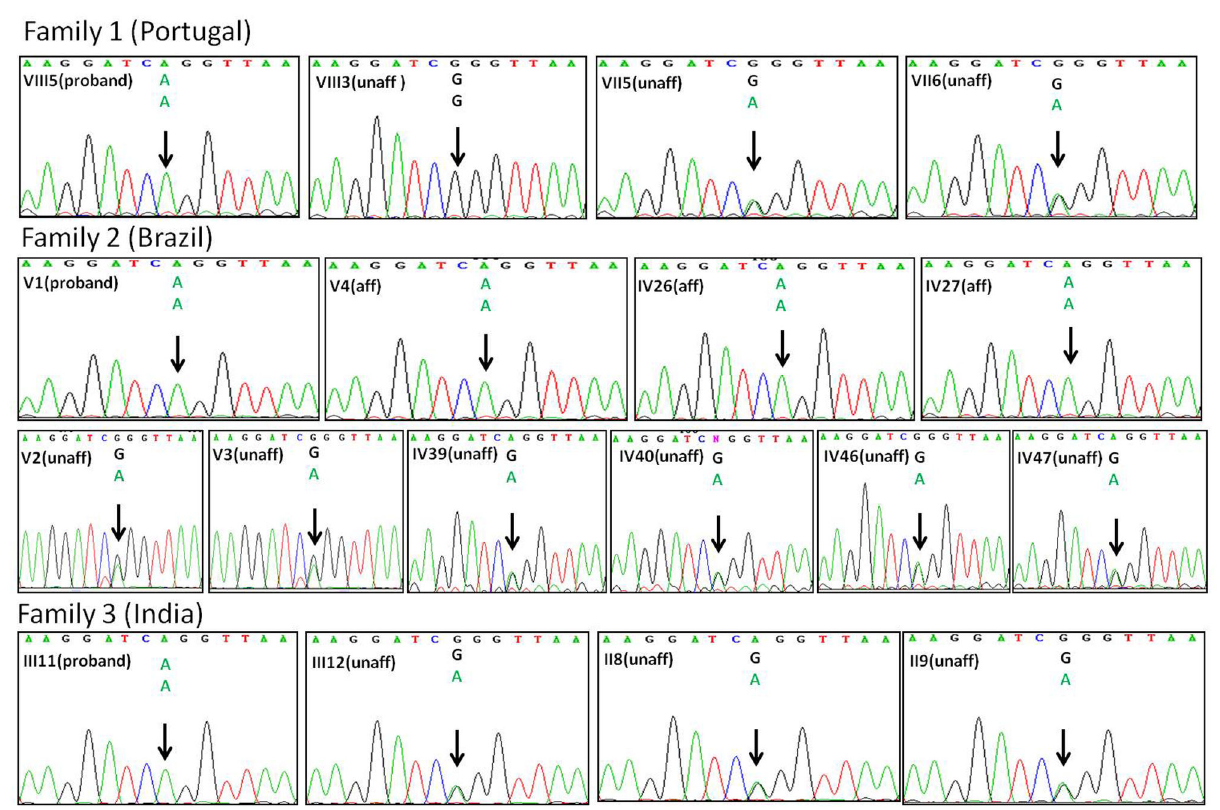
Figure 2. Confirmatory sequencing. Sanger sequencing to confirm exome sequencing data with a mutation in the CONNEXIN 43 gene GJA1 in position c.716G>A (p.Arg239Gln). Data shown for Family 1 (VIII5 proband; VIII3 unaffected sibling; VII5 and VII6 heterozygous parents), Family 2 (V1 proband, V4 affected cousin; IV26 and IV27afffected aunts; V2 and V3 unaffected cousins; IV39 and IV40 heterozygous parents of V1; IV46 and IV47 heterozygous parents of V4) and Family 3 (III11 proband; III12 unaffected sibling; II8 and II9 heterozygous parents).